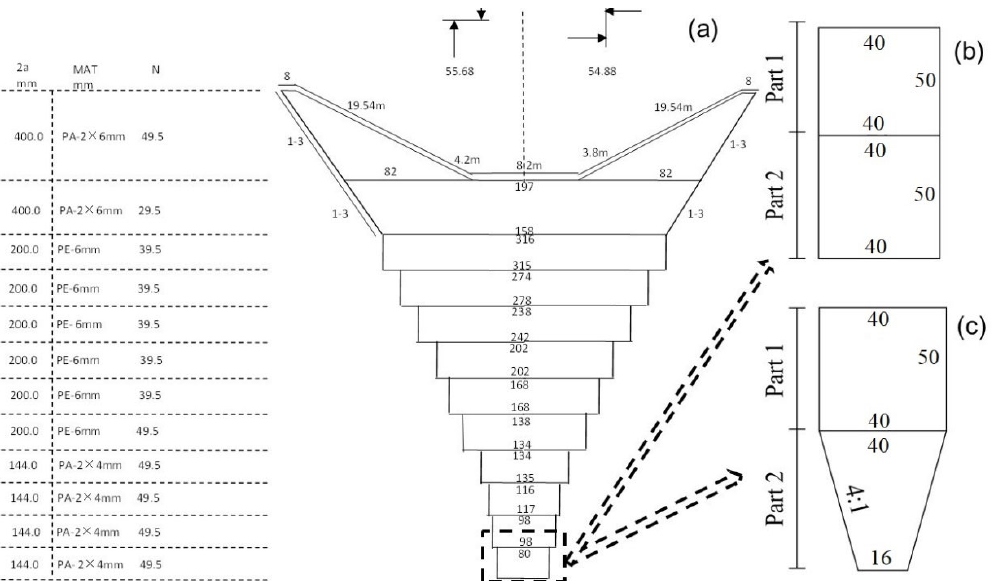
Figure 1. Schematic net plan of: ( a ) Antarctic krill trawl, ( b ) Codends 1 and 3, and ( c ) Codend 2.